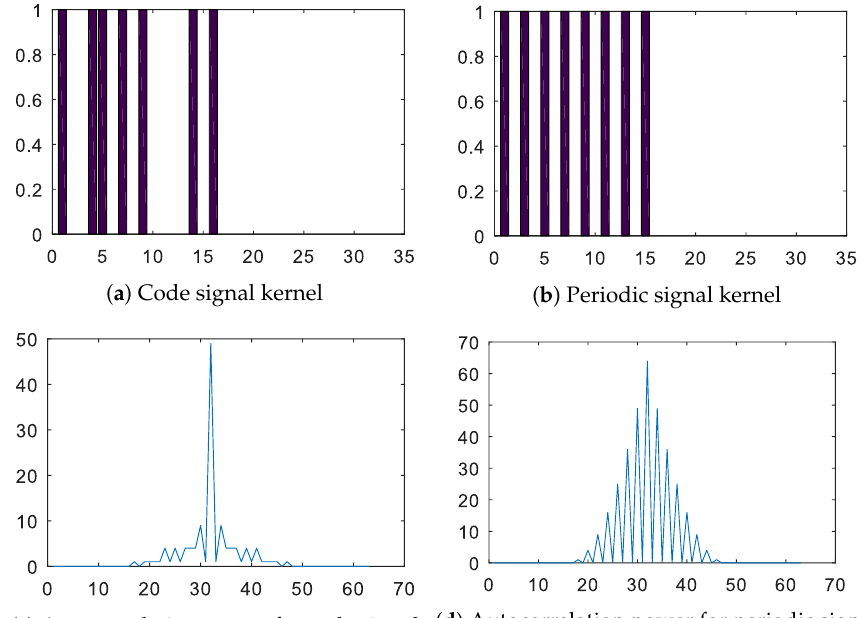
Figure 5. Code signal kernel and its autocorrelation power in comparison to a periodic/repetitive signal. Selected unique code can be robustly detected using correlation because of distinctive peak obtained in its autocorrelation result.